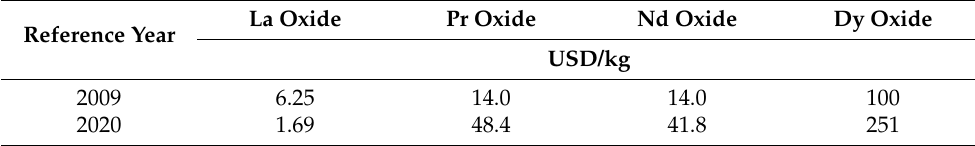
Table 2. Market price of REE oxides, comparison between 2009 [54] and 2020 [49].